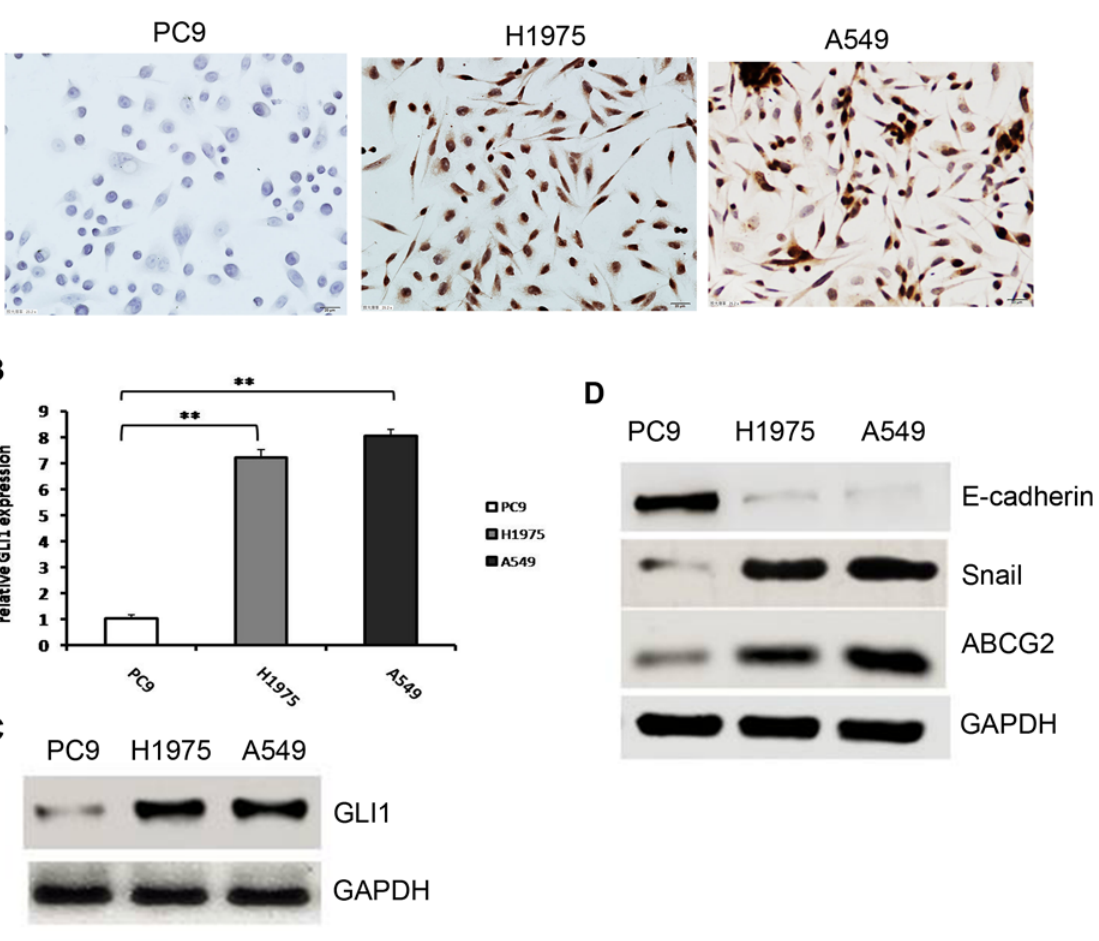
Fig 1. Hh pathway activity in EGFR-TKI-sensitive and -resistant cells. (A). Differences in GLI1 expression in EGFR-TKI-sensitive and -resistant NSCLC cells determined with immunocytochemistry. GLI1 was expressed in the nuclei of EGFR-TKI-resistant cell lines A549 and H1975, but GLI1 expression was negative in the EGFR-TKI-sensitive cell line PC9. (B). Relative GLI1 mRNA expression in EGFR-TKI-sensitive and -resistant NSCLC cells determined by Q-PCR; The expression of PC9 was significantly lower than that of H1975 and A549; ** ( P < 0.01). (C). Differences in GLI1 expression in EGFR-TKI-sensitive and -resistant NSCLC cells determined by western blot. (D) Differences in E-cadherin, Snail, and ABCG2 expression in EGFR-TKI-sensitive and -resistant NSCLC cells determined by western blot.